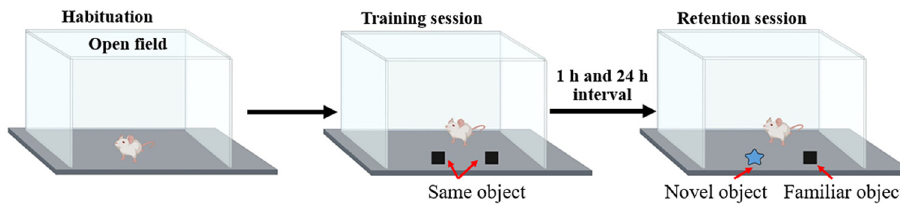
Figure 2. Representative procedure for Morris water maze test.